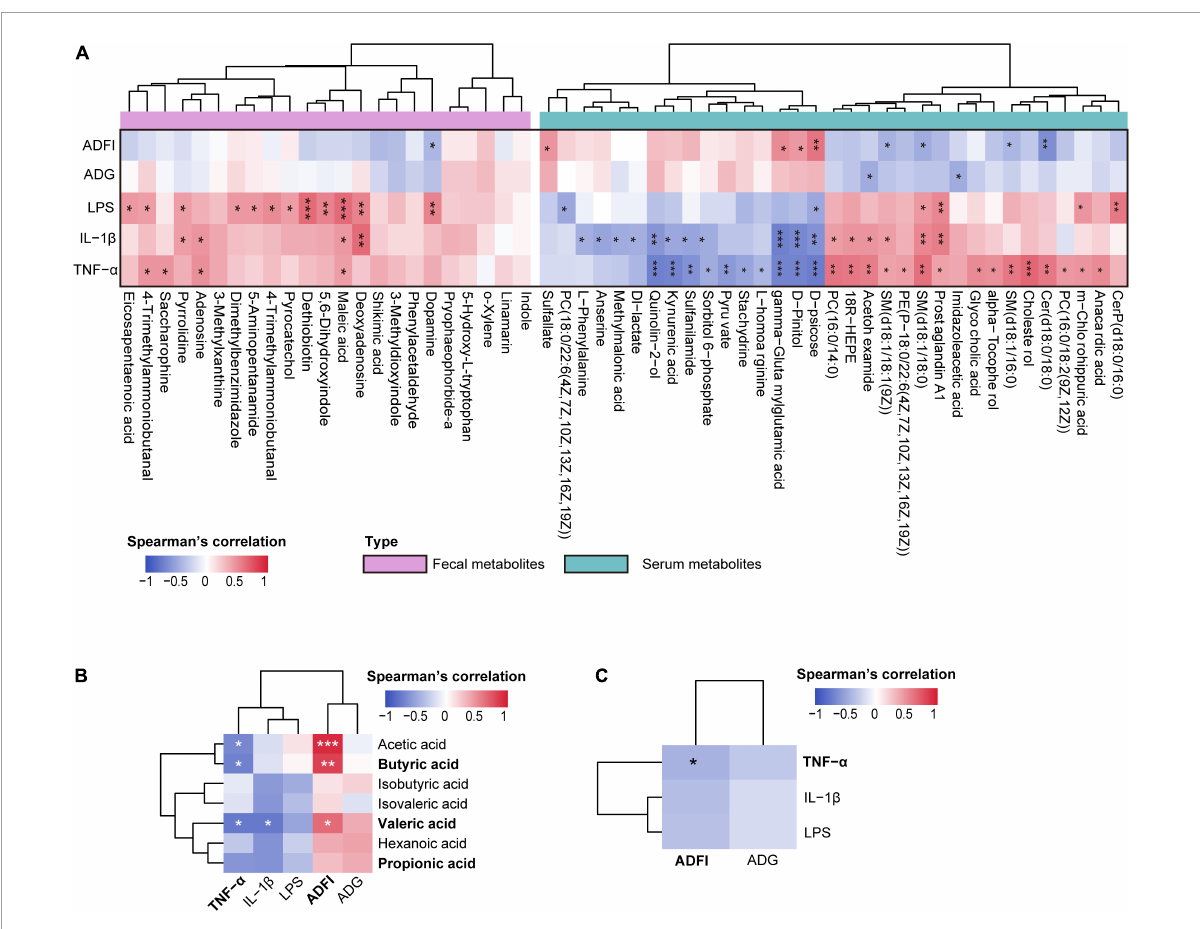
FIGURE6 (A) Spearman’s correlation analysis between differential metabolites (colonic contents and serum) and clinical phenotype indices. (B) Spearman’s correlation analysis between the colonic short-chain fatty acids (SCFAs) and clinical phenotype. (C) Spearman’s